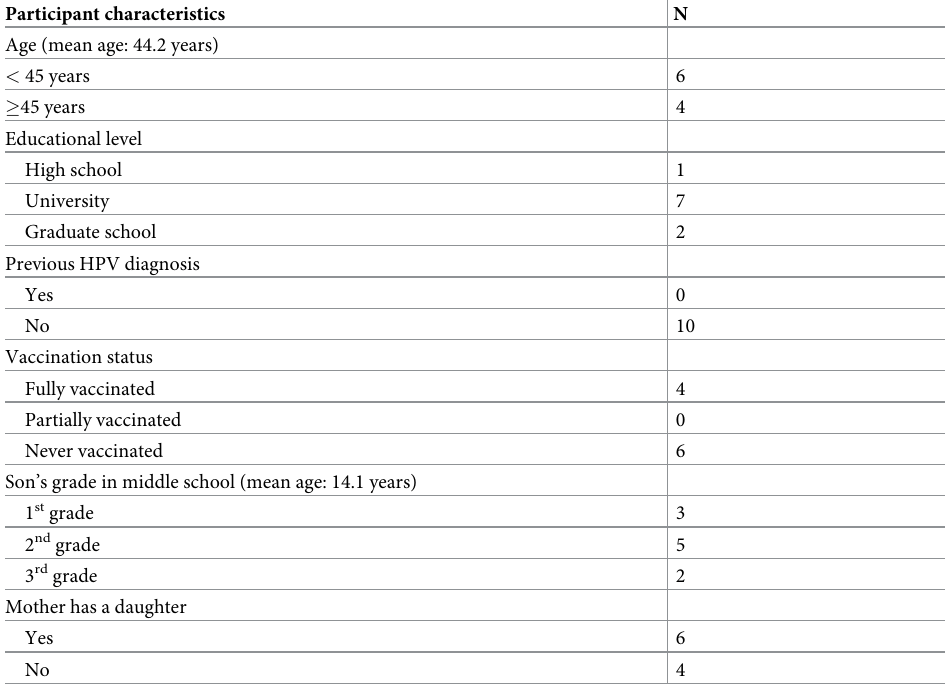
Table 1. Characteristics of the interviewed mothers participating in the study (N =